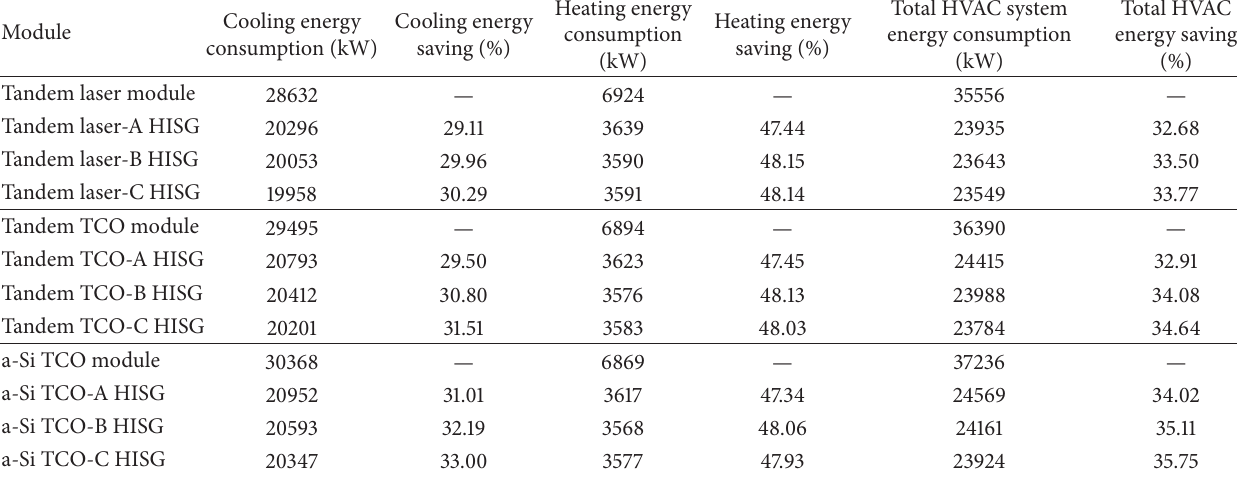
Table 8: Simulation results for energy consumption of HVAC systems for the building body in the Tainan region of